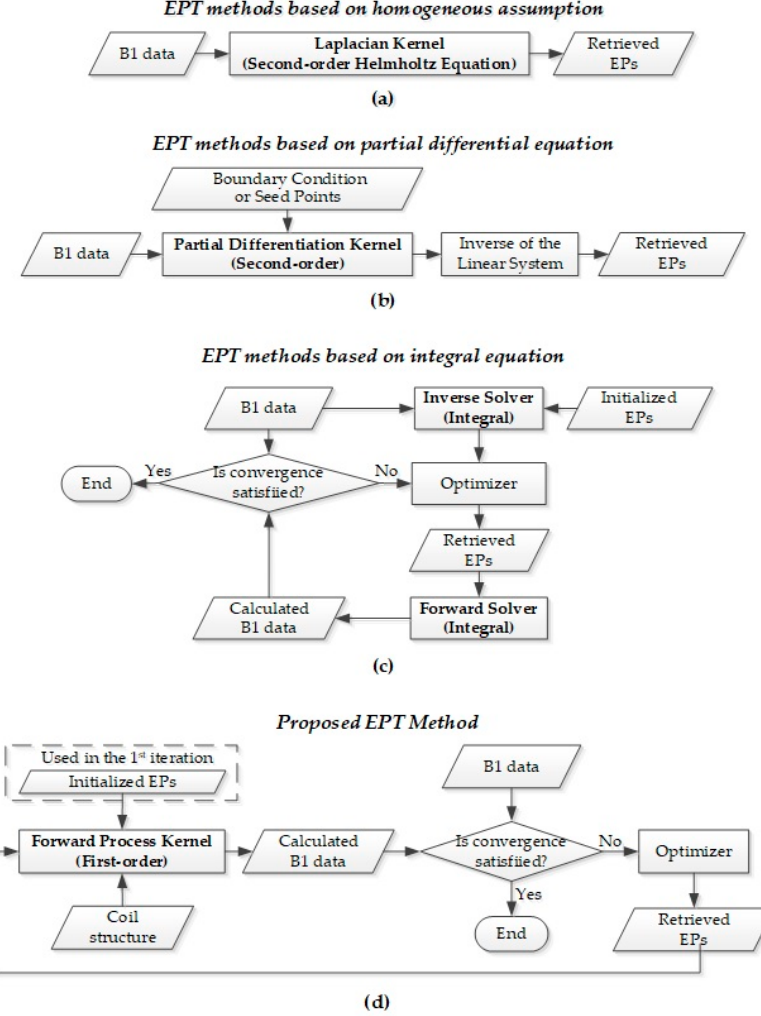
Figure 1. Frameworks of different types of Electrical Properties Tomography (EPT) methods, ( a ) the local homogeneity assumption (LHA)-based solution [7,8], ( b ) the second-order differential wave equation-based solution [16–20], ( c ) integral equation-based solution [11,23–26], and ( d ) the proposed EPT approach. It is noted that the proposed method finds the EPT solution without accessing the phase information of the radiofrequency (RF)